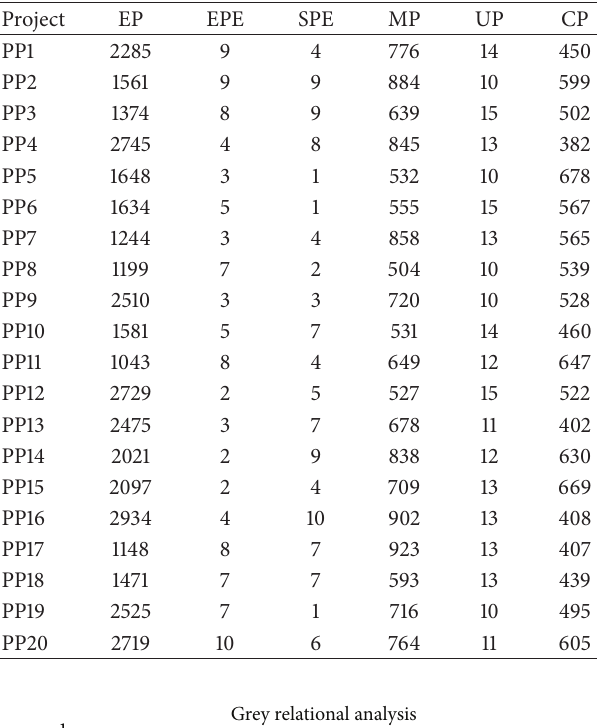
Table 1: The input data for project selection.